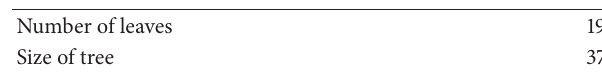
Table 4: Classification results of 400 user datasets.